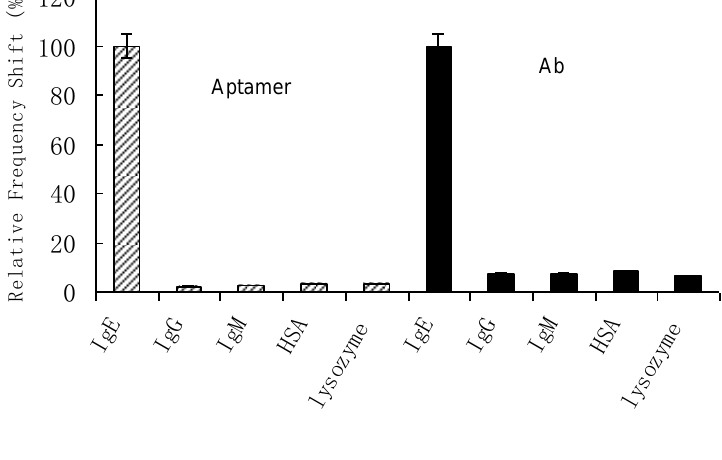
Figure 2. Comparison of the detection specificity between aptamer-based biosensor and antibody-based biosensor. The HSA, IgG and IgM were tested at a concentration of 500 mg/L and diluted in the same buffer (10 μM Tris-HCl buffer, pH 7.9) (interaction time: 15 min). The lysozyme was tested at a concentration of 1 mg/L. The testing concentration of IgE was 100